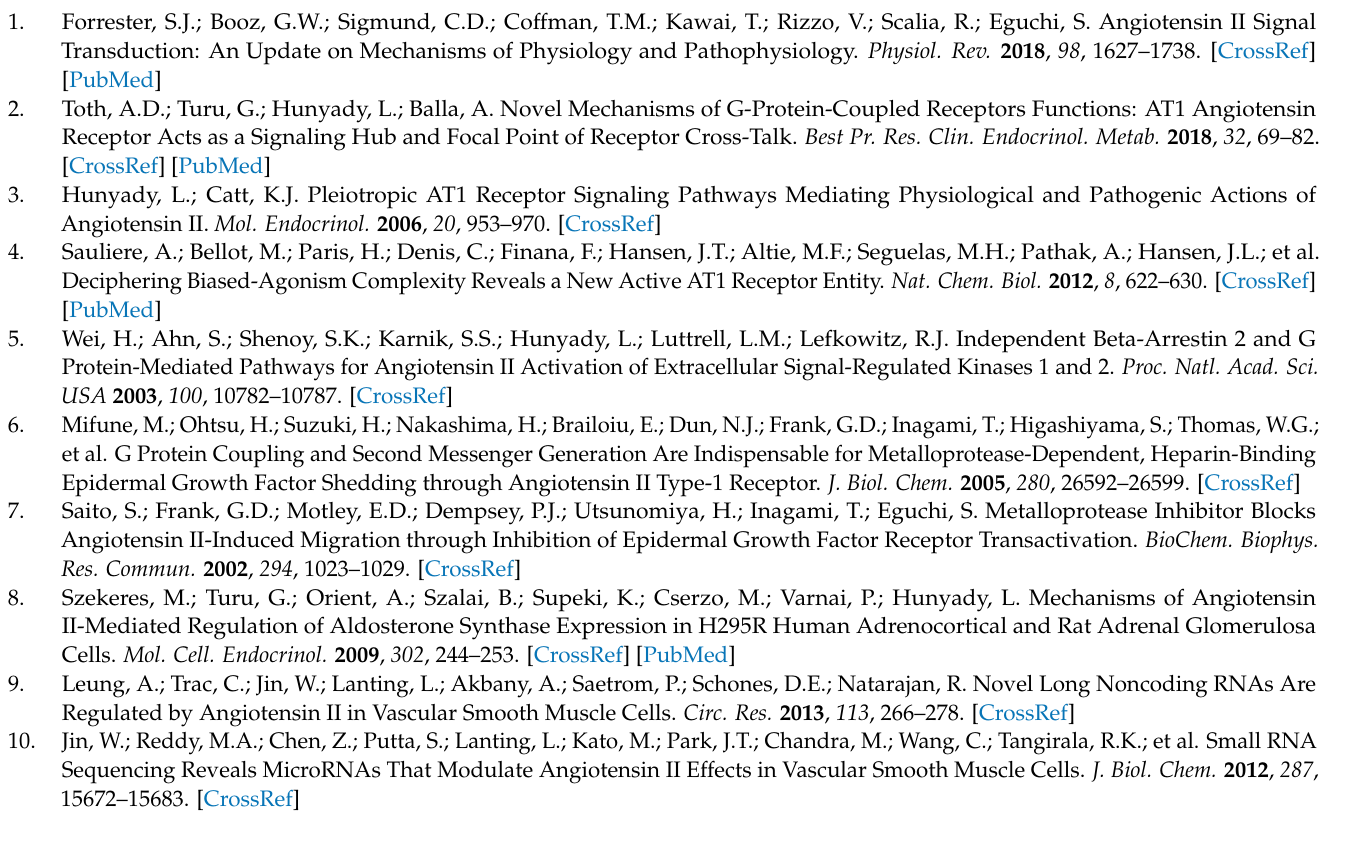
Figure S2. Role of calcium signal in gene expression changes of DUSP isoforms in VSMCs; Figure S3. Evaluation of the contribution of PKC signal transduction in the AngII- and EGF-induced gene expression changes of DUSP isoform in VSMCs; Figure S4. Effect of PDGFR and VEGFR and IGF-1R tyrosine kinase inhibitors on AngII and EGF mediated induction of DUSP expression in vascular smooth muscle cells; Figure S5. Importance of MAPK cascade activation in AngII mediated upregulation of DUSP isoforms in vascular smooth muscle